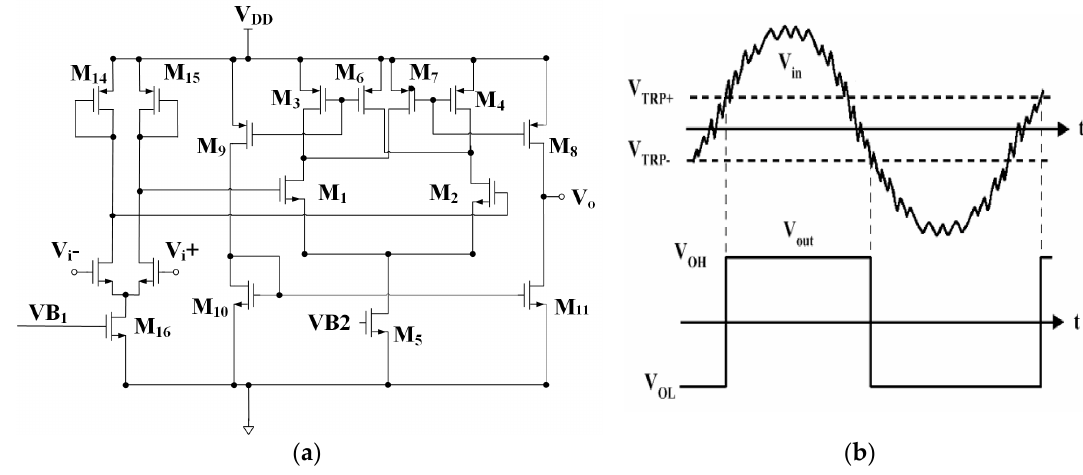
Figure 7. ( a ) The hysteresis comparator with pre-amplifier; ( b ) positive and negative trip